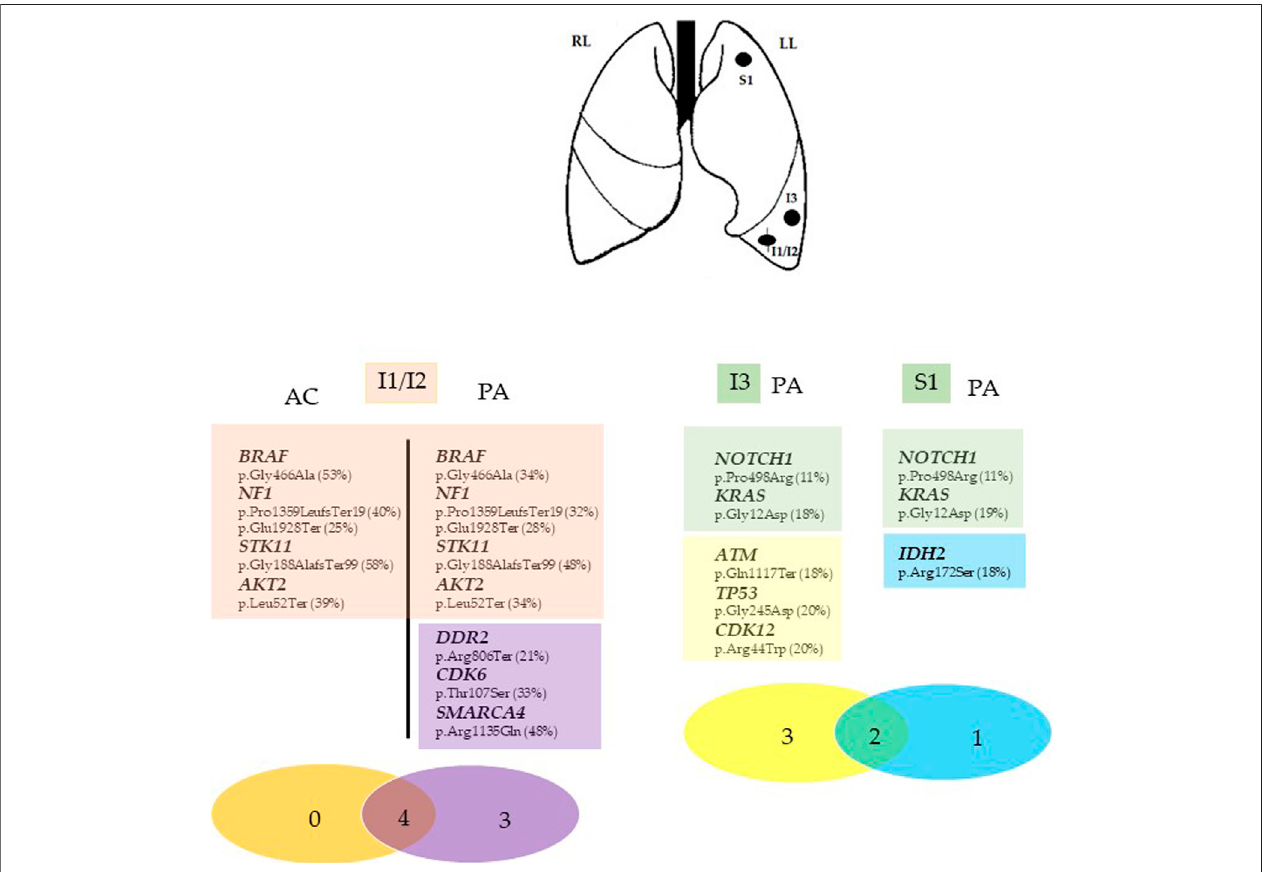
FIGURE 2 | Summary of the genomic fi ndings of Case 1. Genes with mutations identi fi ed in each tumor entity of the inferior and superior left lung (I1/I2, I3, and S1) are listed as symbol and aminoacidic changes (% mutant allele fraction). The Venn diagram was used to show the shared mutations (red circle in I1/I2 nodule and green circle in I3 and S1 nodules) and exclusive mutations for each tumor fraction. The different numbers represent the somatic mutations in the corresponding samples, whereasthenumberintheoverlappedregionsred(I1/I2)andgreen(I3andS1)areubiquitoussomaticmutationssharedbythetwoconcurrenttumorcomponents (I1/I2)andbythetwoisolatedadenocarcinomanodules(I3andS1)inthesamepatient.I1/I2,mixedcarcinoid/adenocarcinomatumor;I3,inferioradenocarcinomatumor, S1, superior adenocarcinoma tumor. Asterisks (*) indicate the different mutation in the same gene. LL, Left lung; RL, right lung. AC, atypical carcinoid; PA, pulmonary adenocarcinoma.